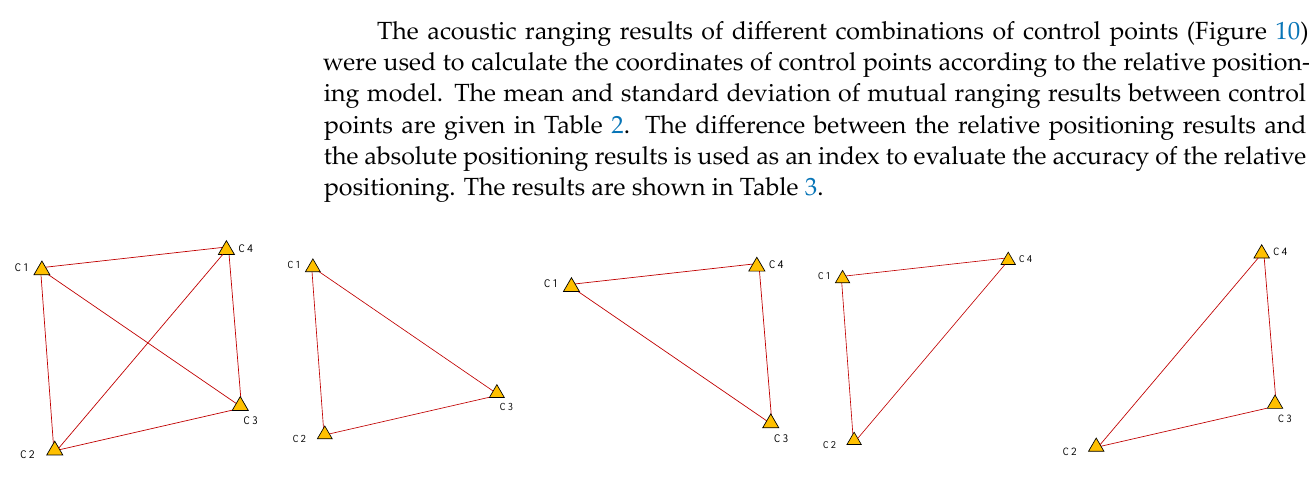
Table 1. The coordinates of seafloor control points determined by circle-sailing.